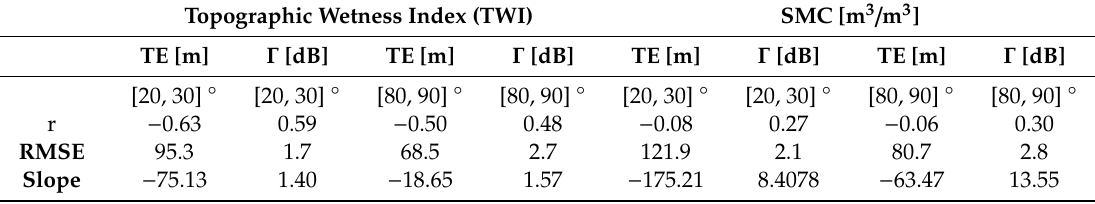
Table 1. Statistics (Pearson correlation coe ffi cient r, RMSE, and slope of the linear fits) of the scatter plots of CyGNSS-derived TE and Γ with TWI and SMAP-derived SMC over the selected target area over North